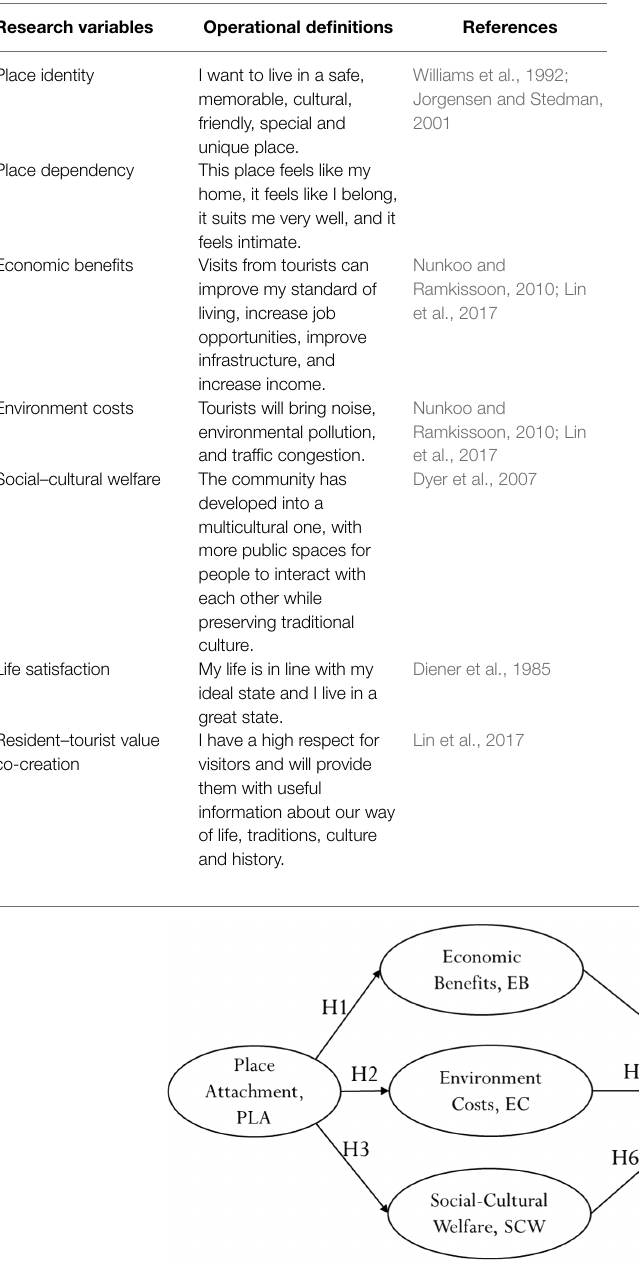
TABLE 1 | Operational definitions of research